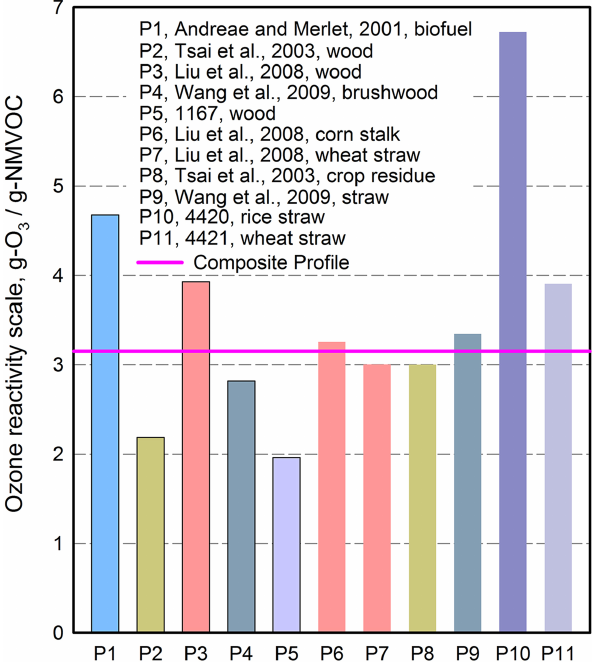
Figure 14. Sensitivity of OFPs to profile selection for the residential biofuel